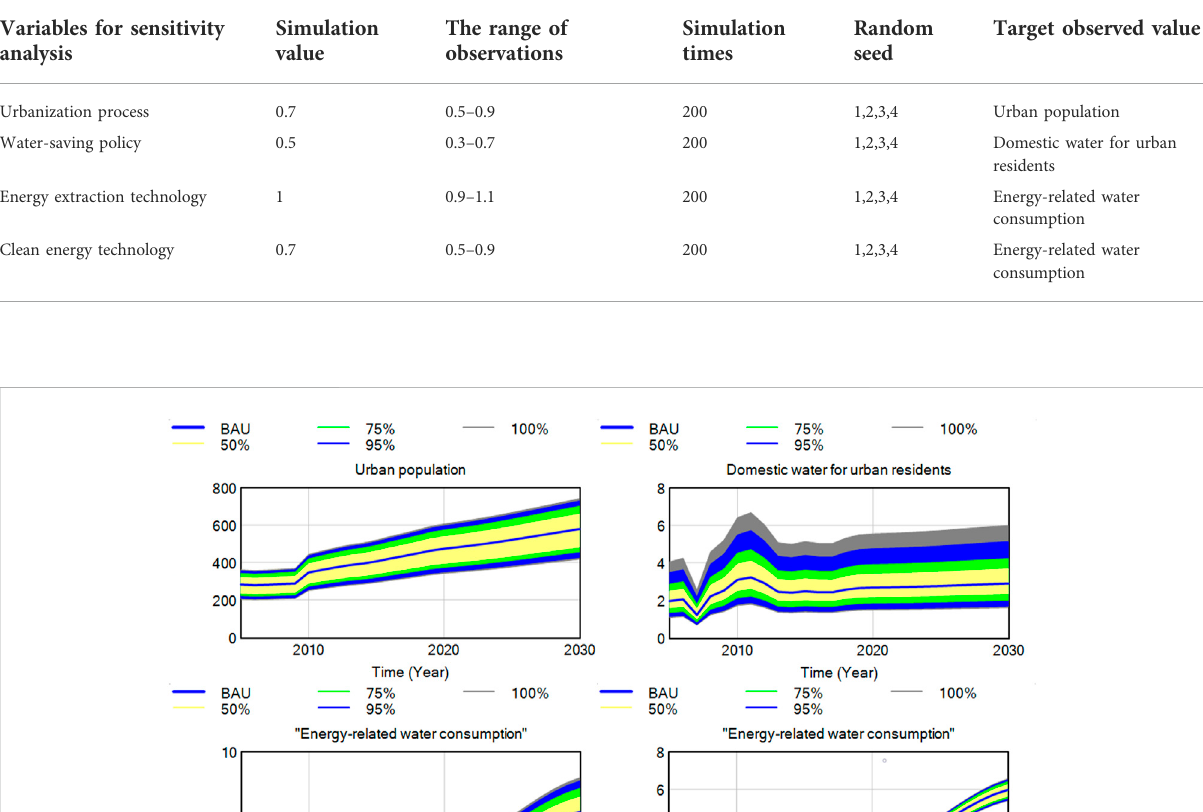
TABLE 1 Variable selection and parameter setting for sensitivity analysis.